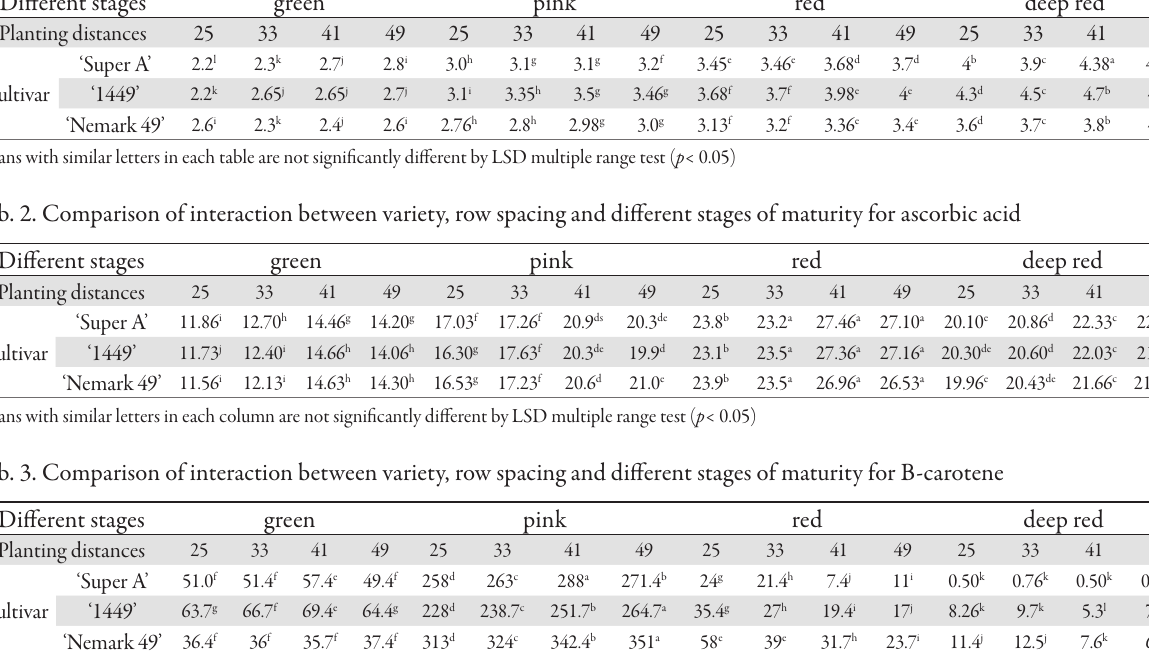
Tab. 1. Comparison of interaction between variety, row spacing and different stages of maturity for TSS Different stages green pink red deep red Planting distances Cultivar